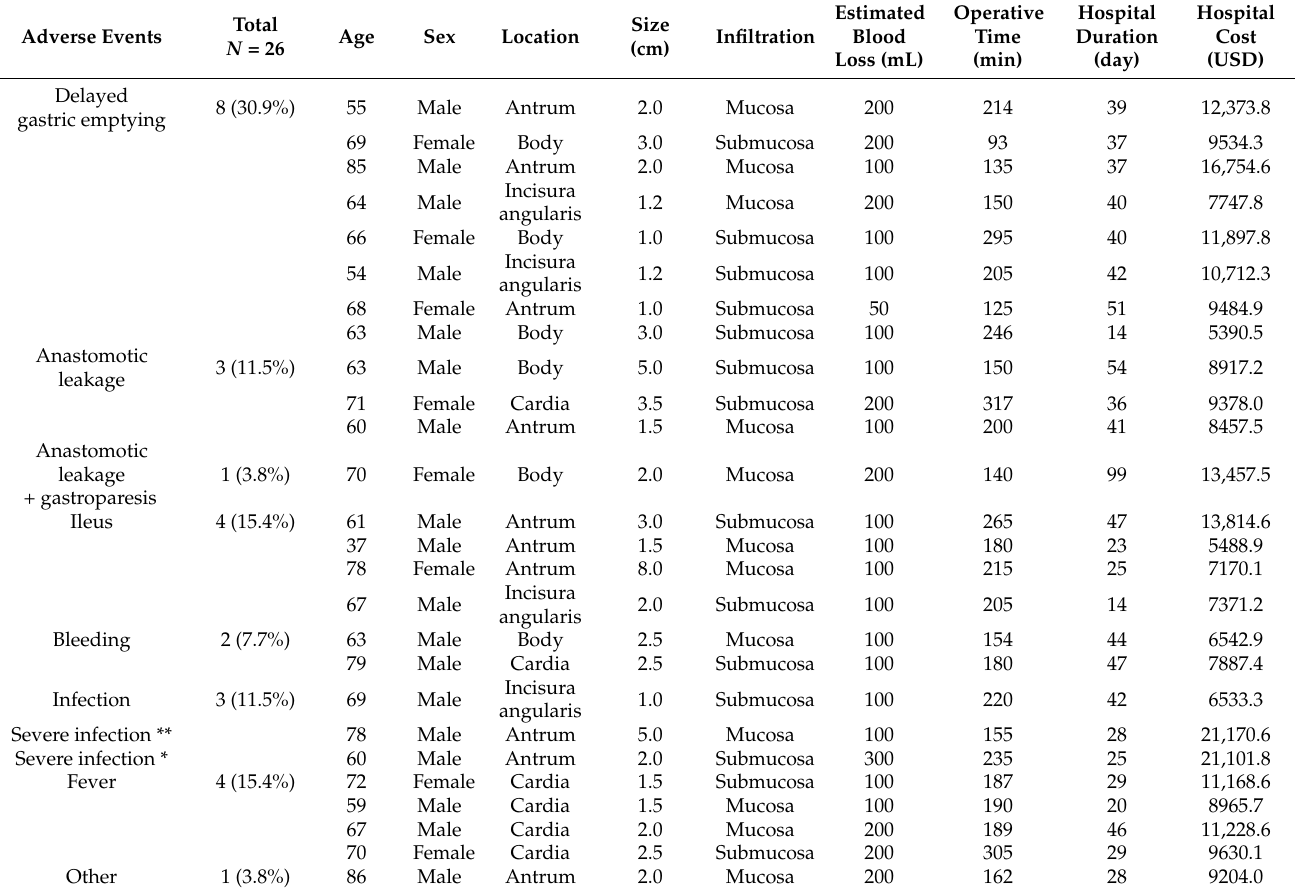
Table 4. Adverse events after surgery treatment for early gastric cancer